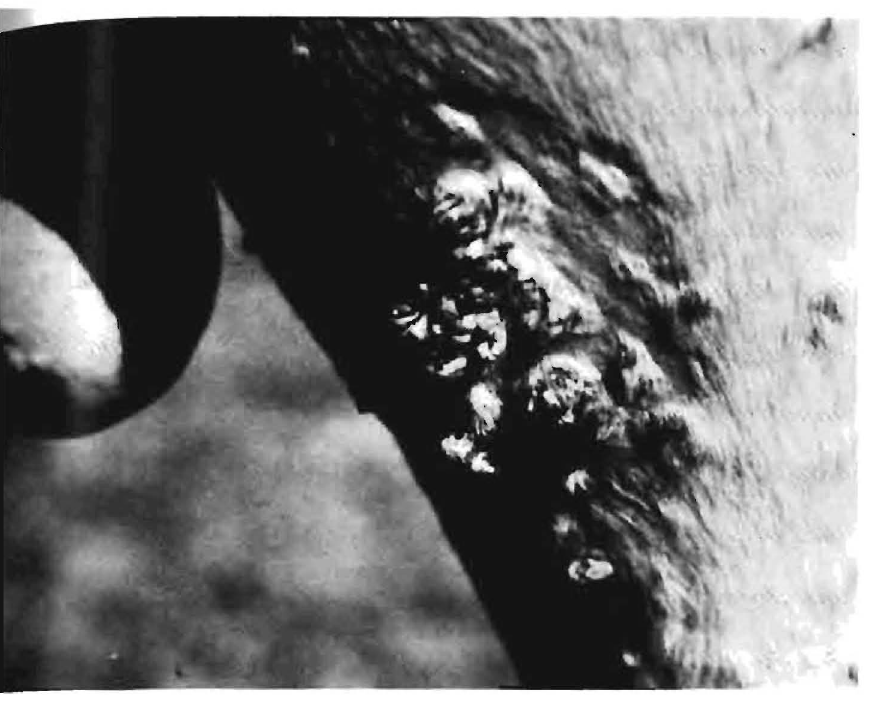
Fig. I: Inner caudal thigh ofa Minia ture pony illustrating early lesions consisting of outward projecting spicules of